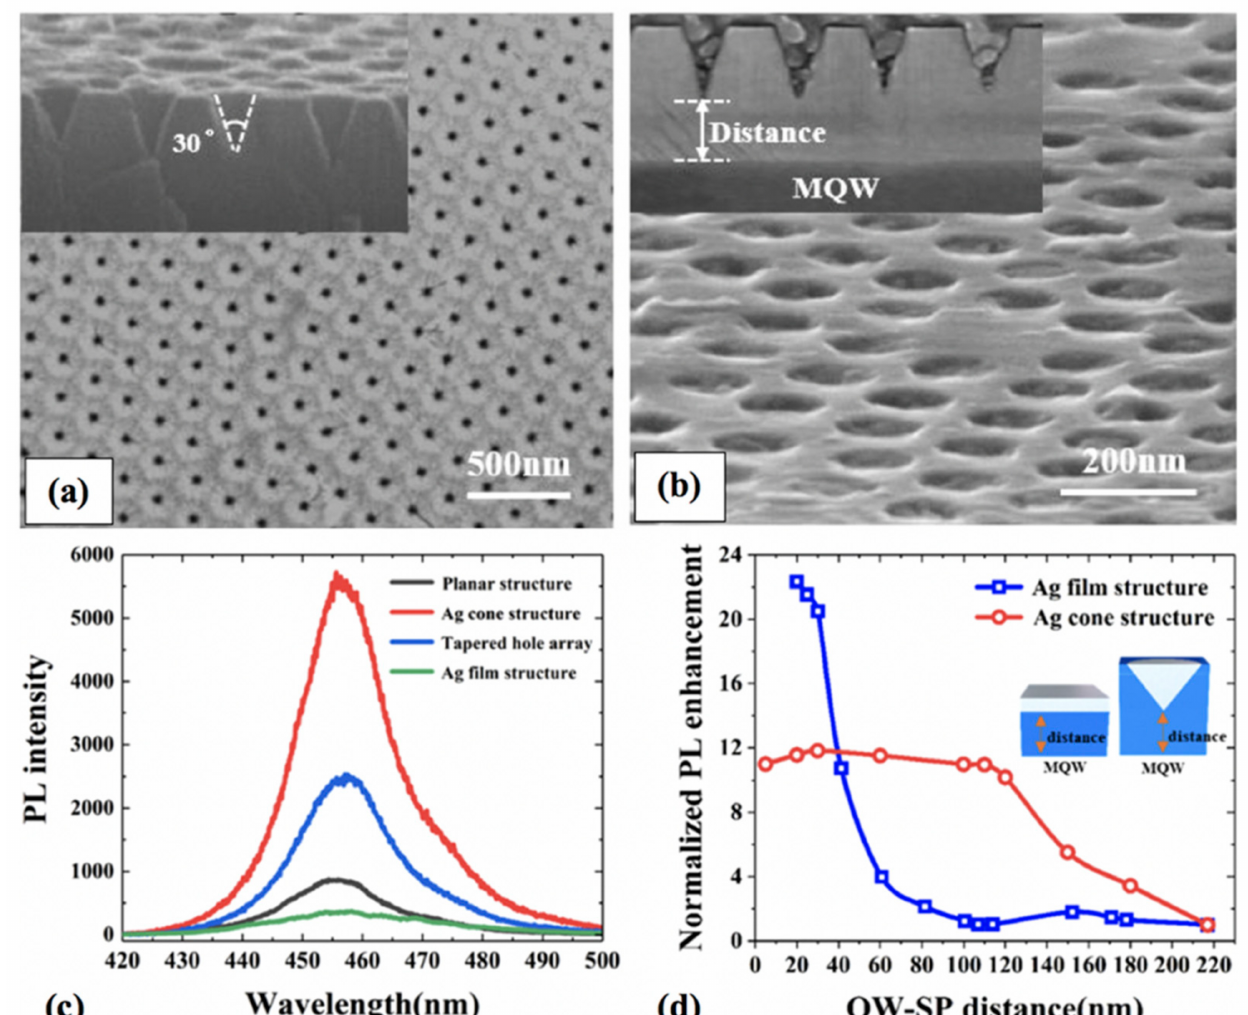
Figure 6. ( a ) Nano-cones on the p-GaN surface and ( b ) embedded tapered Ag; the inset images are side view of nano-cones on the p-GaN surface and embedded tapered Ag, respectively. ( c ) PL spectra of cone and plane structures with and without Ag at a coupling distance of 100 nm. ( d ) Normalized PL enhancement of LEDs with Ag cone and film as a function of coupling distance. The inset shows the definition of the QW-SP distance for different structures. Reprinted with permission from [83]. Copyright 2020 The Optical